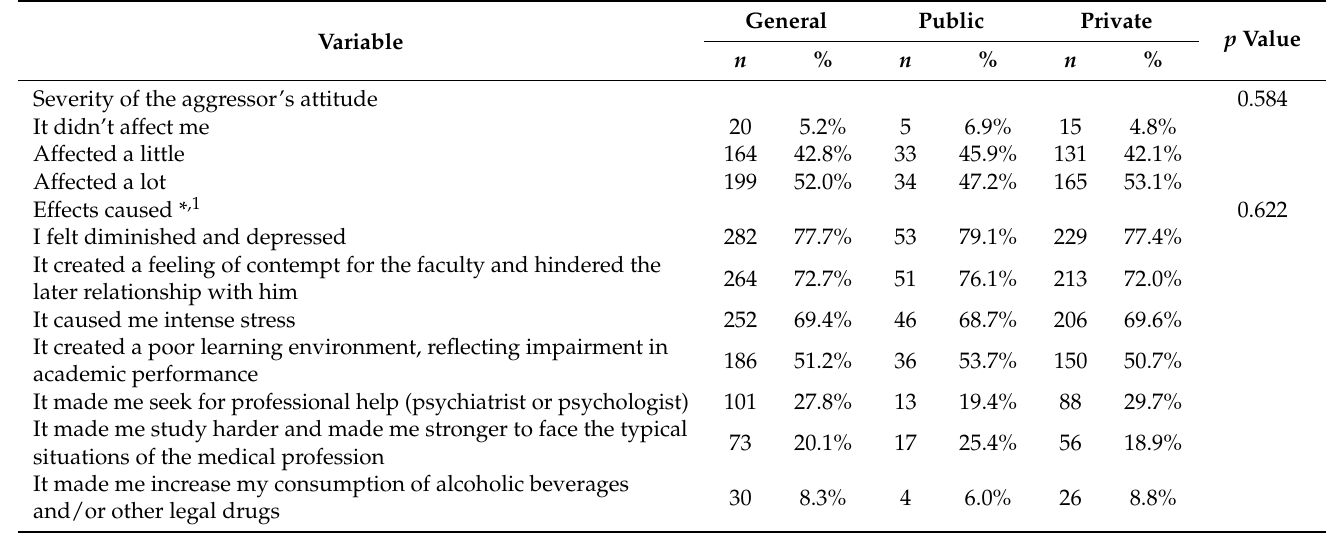
Table 3. Frequency distribution of data related to the impact of mistreatment, by institution.